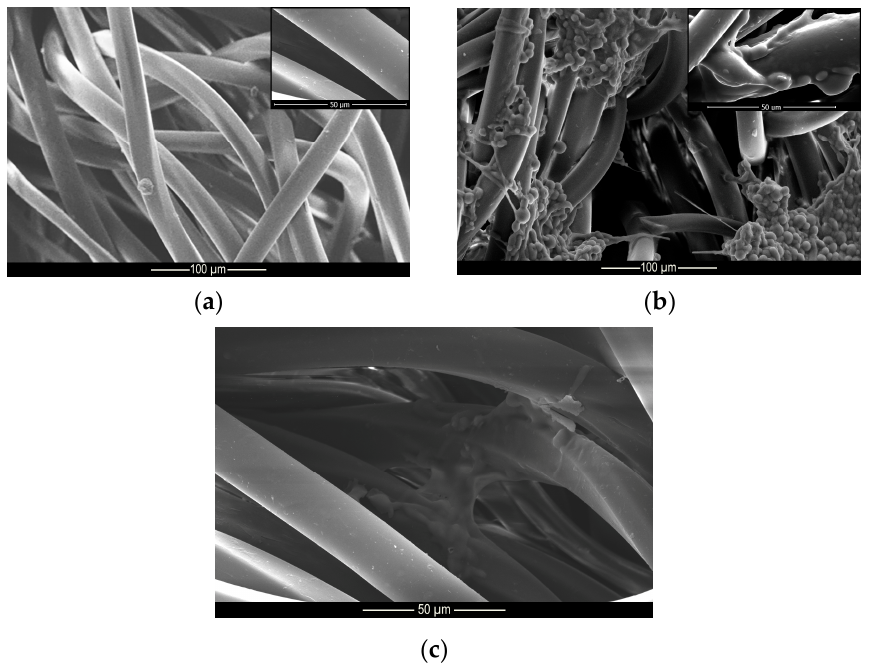
Figure 9. Microscopy of ( a ) untreated, ( b ) treated and ( c ) washed polyamide samples.